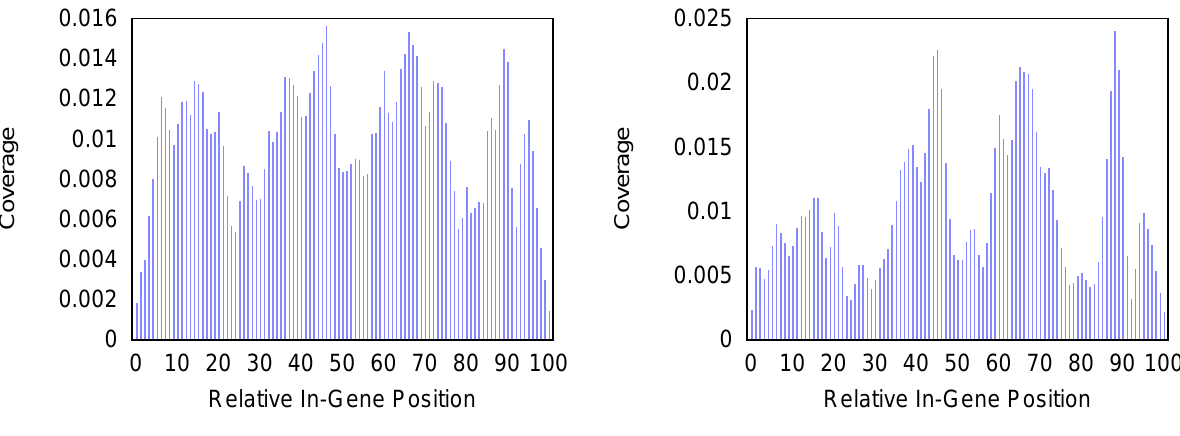
Figure 4. Density of the coverage with markers for gene nad1 as detected by the annotation guided method (left) and the probability based method (right).